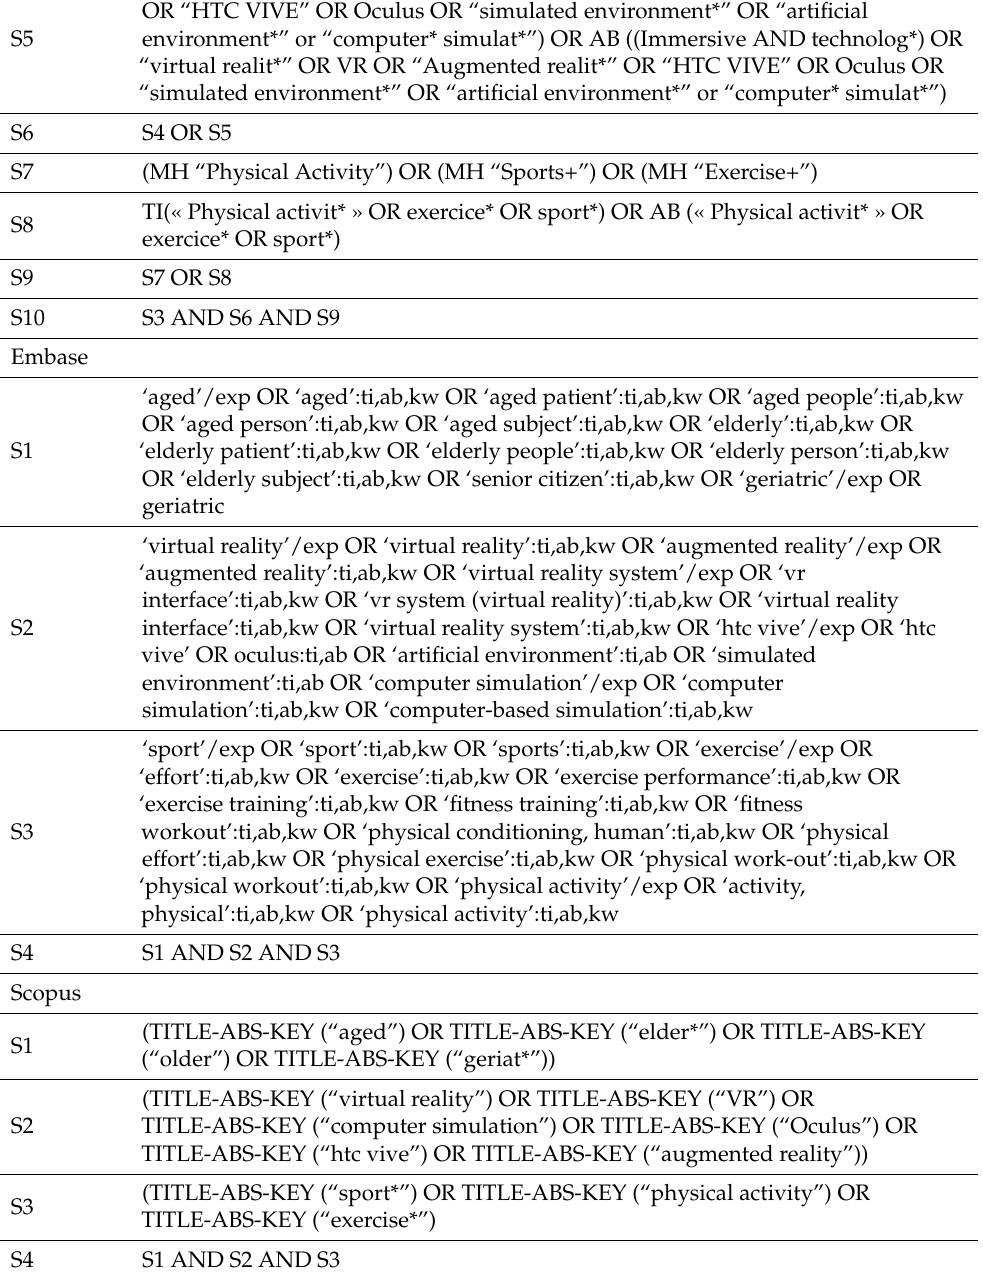
Table A1. Search strategy in each